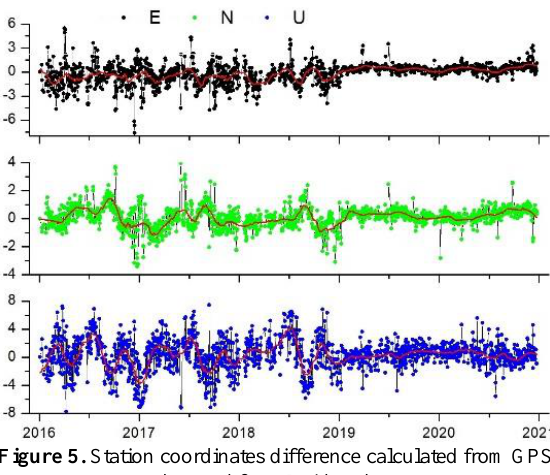
Figure 5. Station coordinates difference calculated from GPS data and from Beidou